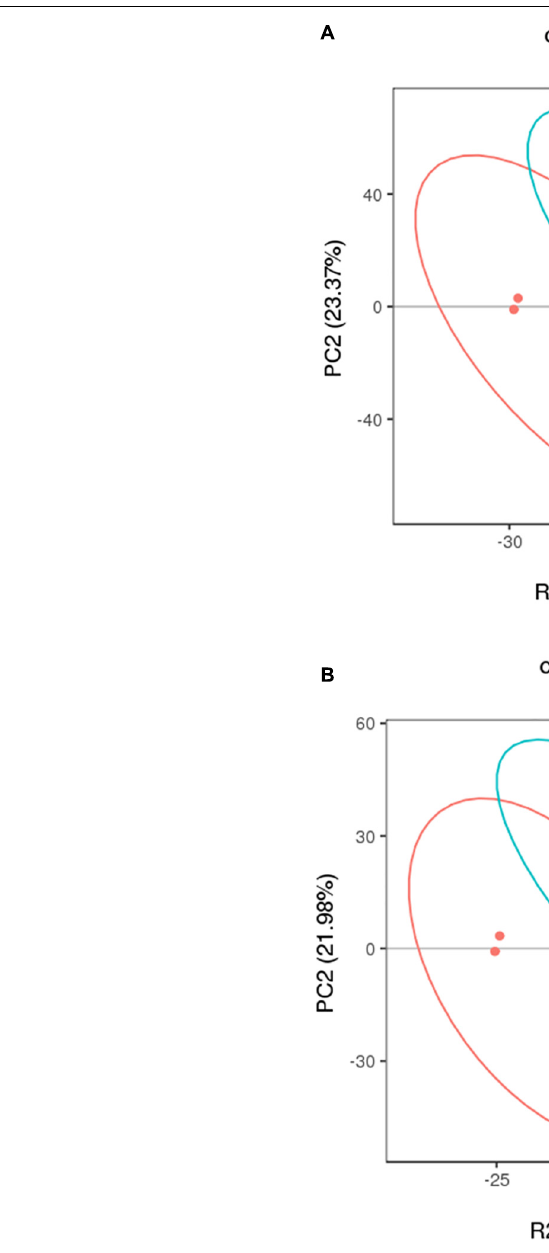
Score) was 2 (Segata et al., 2011). Use the Tax4Fun software to predict the function of all samples (Qin et al.,